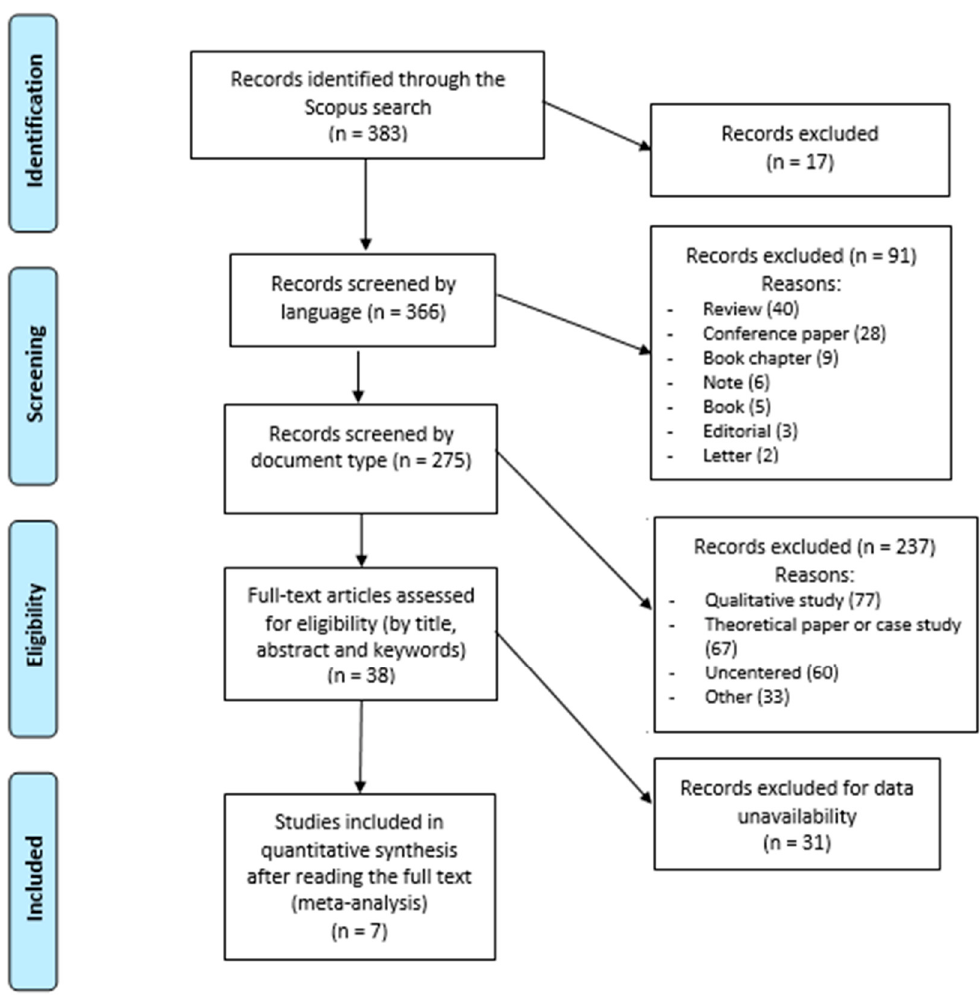
Figure 1. Systematic review flowchart detailing the literature search, number of abstracts screened, and full texts retrieved.